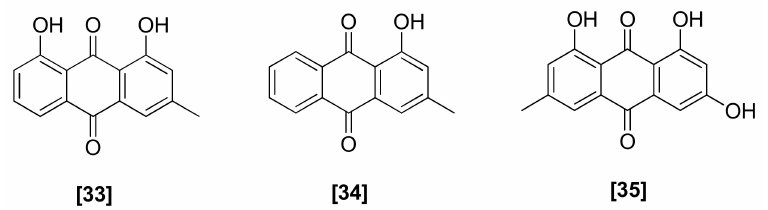
Figure 9. Structures of antifungal anthraquinones from Trichoderma spp.: [33] 1,8-dihydroxy-3-methylanthraquinone, [34] 1-hydroxy-3-methylanthraquinone, [35] 6-methyl-1,3,8-trihydroxyanthraquinone.